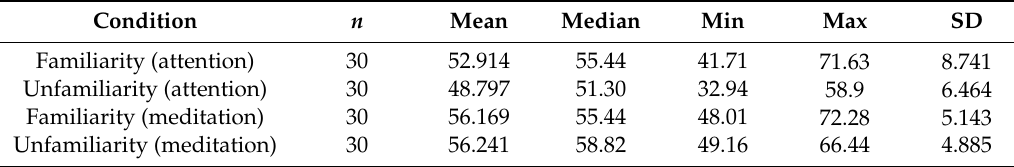
Table 18. Descriptive statistics for attention and